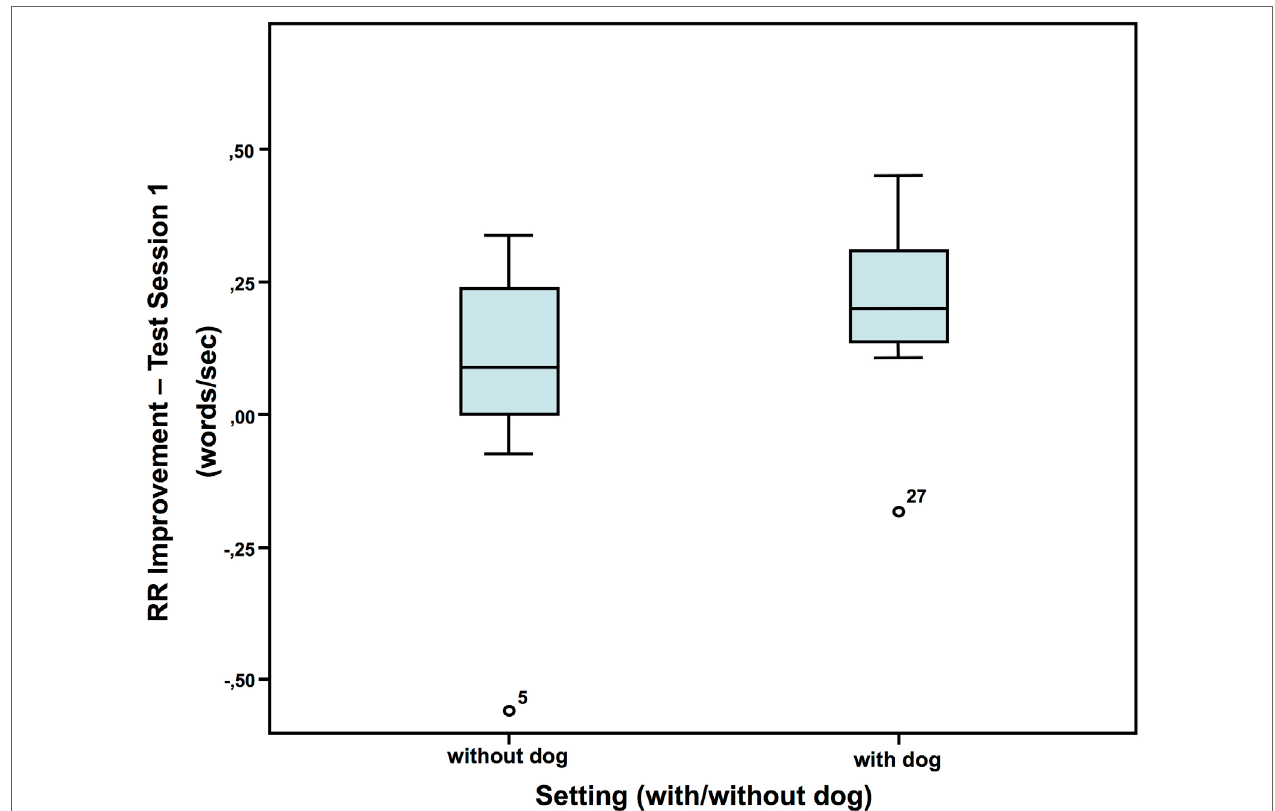
FigUre 1 | Repeated reading improvement